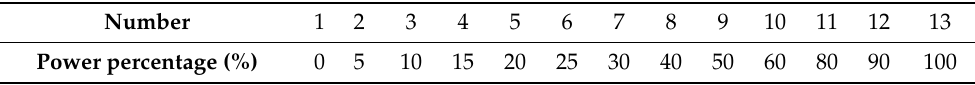
Table 1. Diesel engine conditions employed in the experiment.